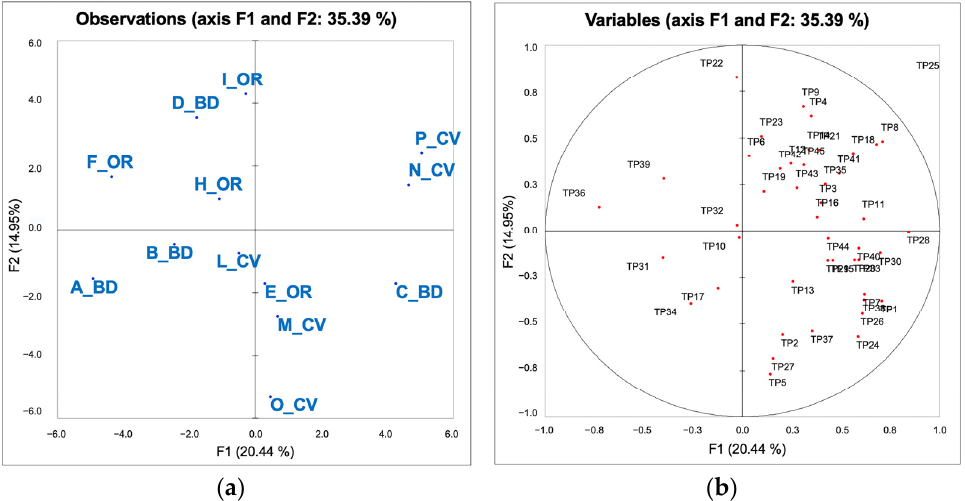
Figure 4. Representation of the Chianti DOCG wines by multiple factor analysis according to the Napping X- and Y-coordinates and typicality scores provided by the panel of experts. ( a ) Wine distribution; ( b ) distribution of the typicality scores (elaborated as supplementary data).